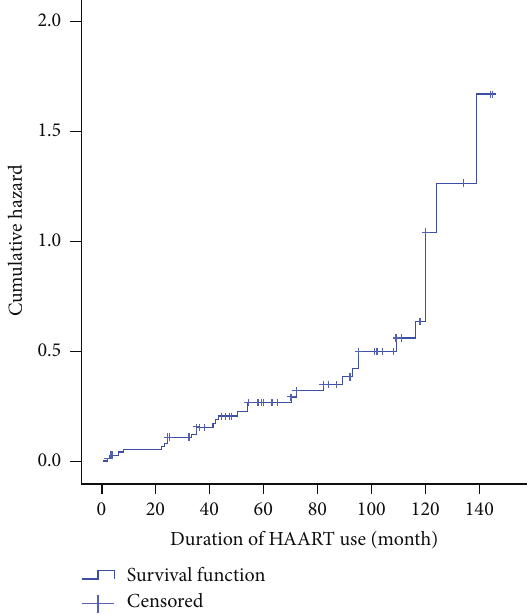
Figure 1: Hazard function of HAART on HIV infected participants with